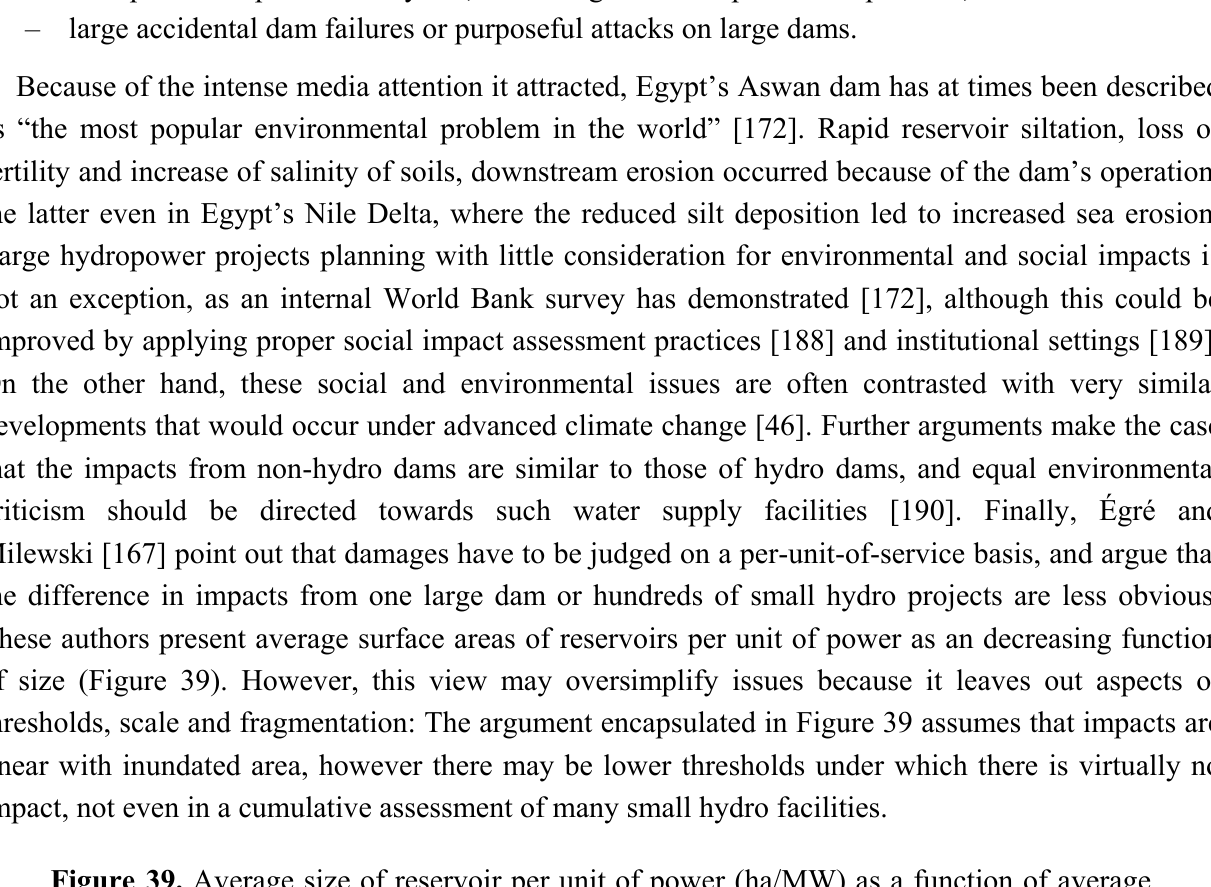
Figure 39. Average size of reservoir per unit of power (ha/MW) as a function of average size of plant (MW) (derived from data tabled in